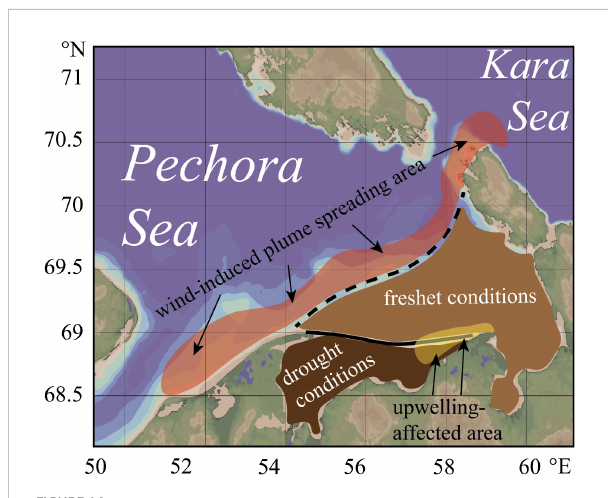
FIGURE 14 Location of the Pechora River plume during drought (dark-brown color) and freshet (light-brown color) conditions, which illustrates seasonal variability of the plume. Wind-induced plume spreading area (red color) and coastal upwelling area (yellow color), which illustrate synoptic variability of the